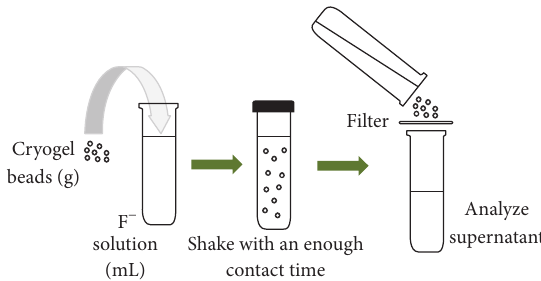
Figure 1: Experimental procedure for adsorption